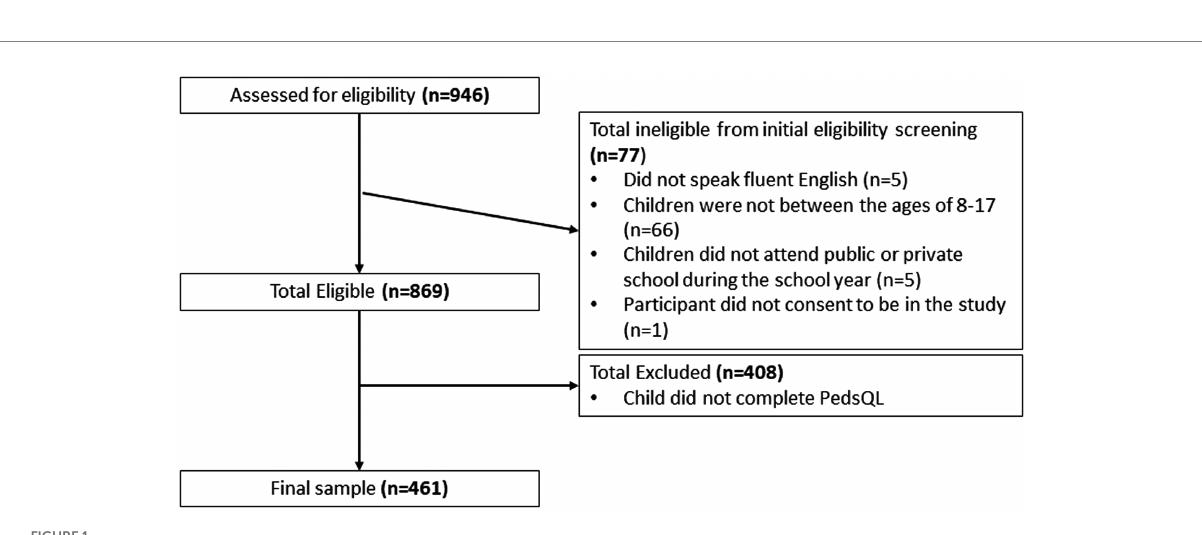
FIGURE 1 Consort diagram describing sample included.